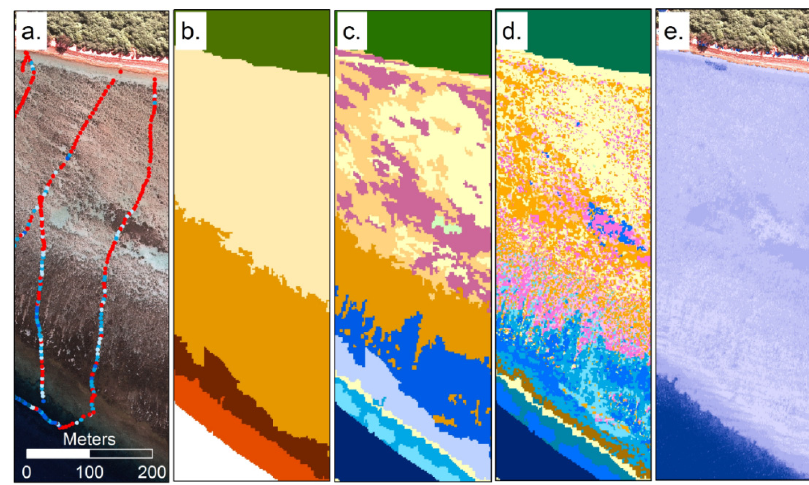
Figure 3 . Examples of remote sensing products for an area of reef south of Heron Island (Southern Great Barrier Reef): ( a ) derived from high spatial resolution imagery and field data; ( b ) where geomorphic zonation; ( c ) benthic community; ( d ) benthic cover type were derived using object based image analysis [84] and ( e ) water depth derived from model inversion analysis of hyperspectral CASI imagery [85].